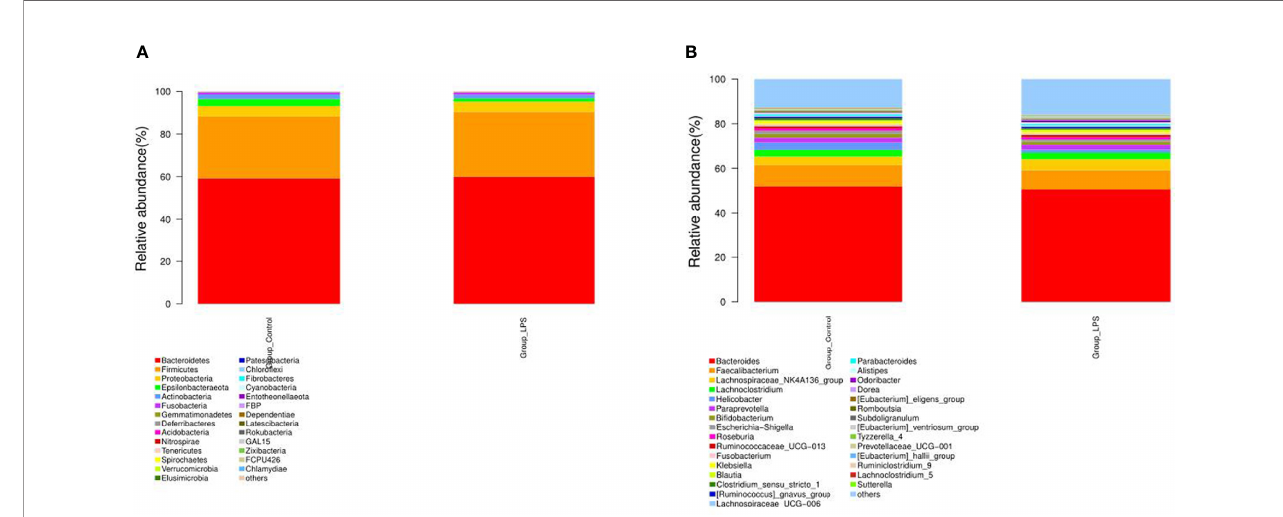
FIGURE 3 | Effect of LPS on the composition of intestinal microbiota in mice. (A) Phylum level. (B) Genus level.